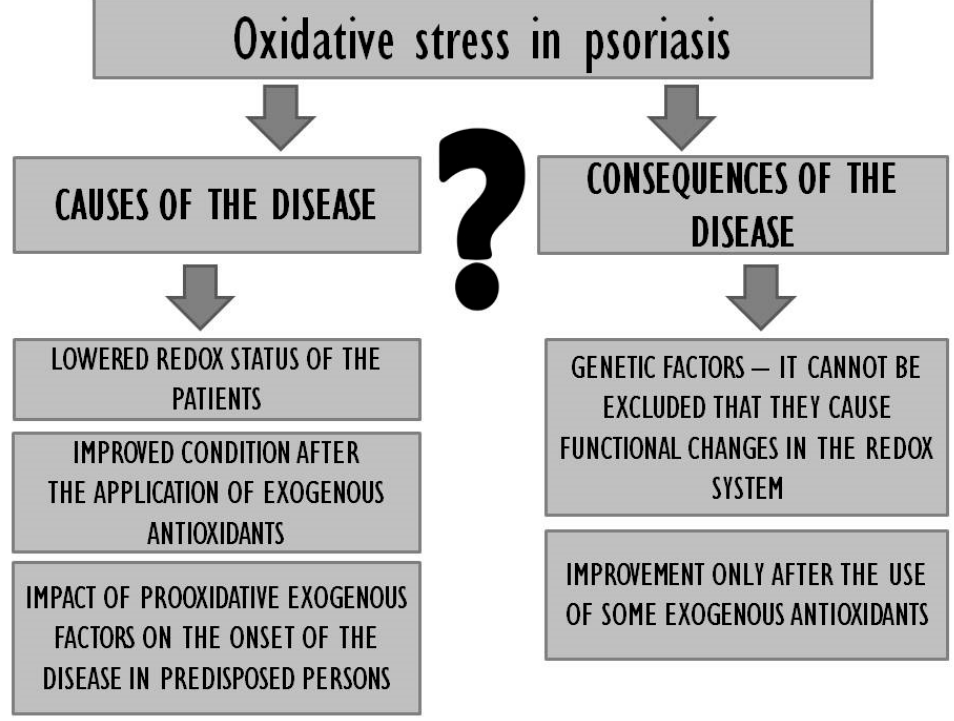
Figure 1. Oxidative stress in psoriasis—causes or consequences of the disease.